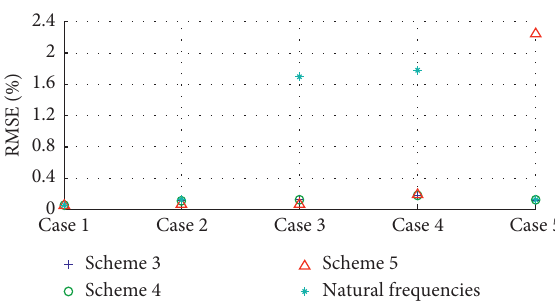
Figure 8: Root mean square errors (RMSE) of the detection results for different